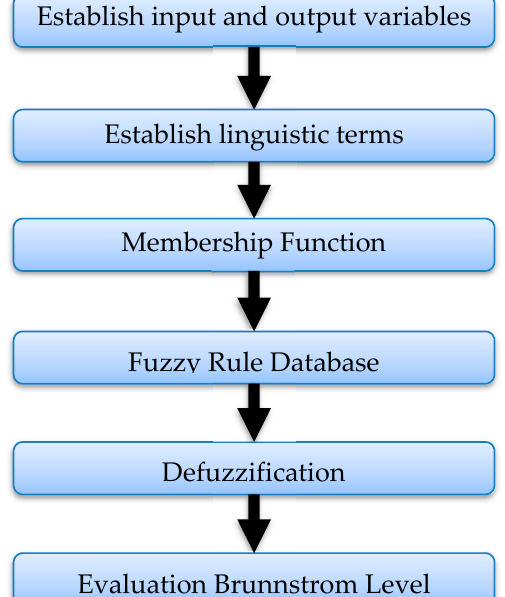
Figure 7. Schematic diagram of BSES Fuzzy System.